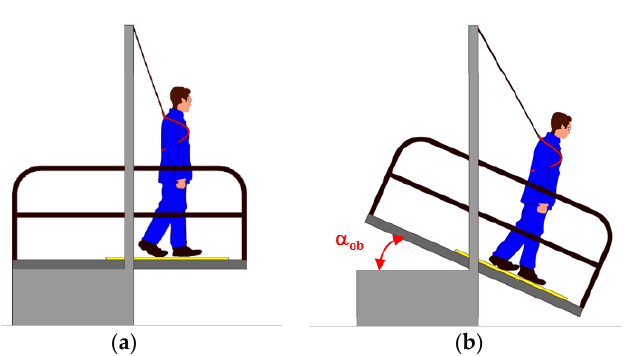
Figure 6. Ramp test: ( a ) starting position, ( b ) position at maximum acceptable angle α ob.